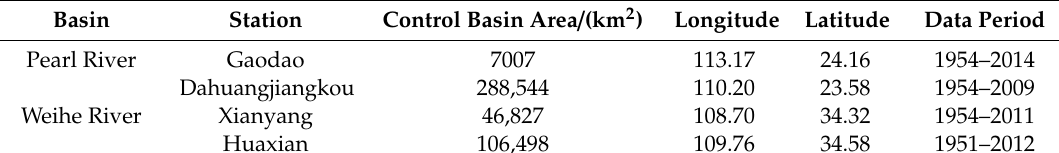
Table 1. The information on the hydrological stations used in this study.